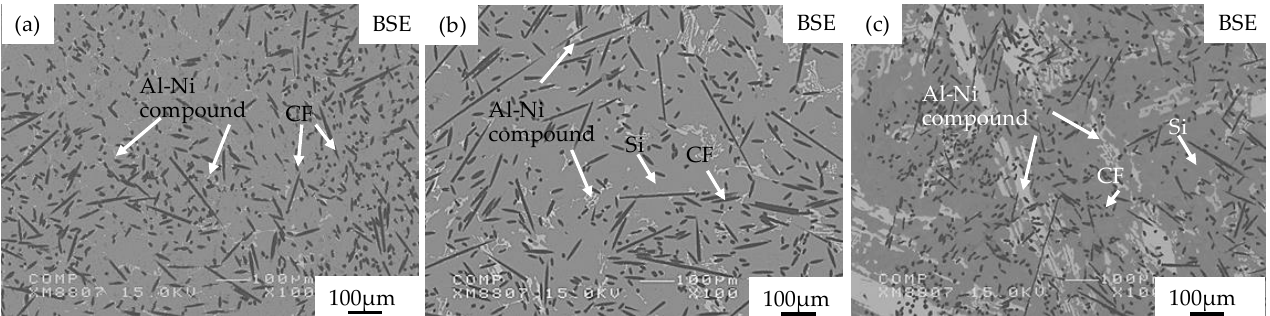
Figure 3. Microstructures of composites: ( a ) Ni plated CSF/A1070 composite, ( b ) Ni plated CSF/A356 alloy composite, and ( c ) Ni plated CSF/A336 alloy composite. Table 2. Volume fraction of CSFs, Al-Ni compounds and Si phases in Ni plated CSF/Al matrix